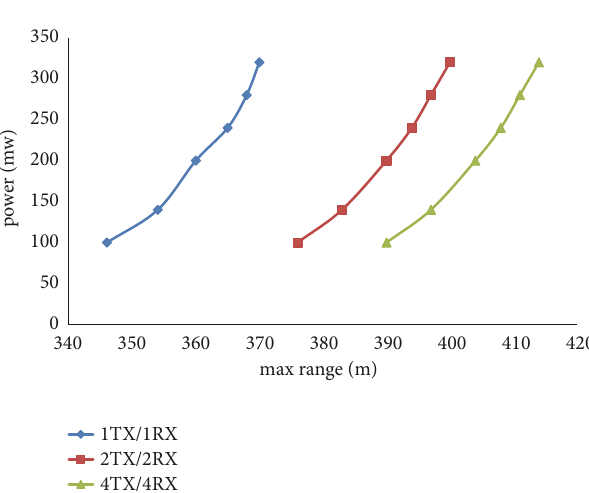
Figure 11: Power (mw) and max range (m) at 𝜆 =1550nm and 𝛼 =190.9db/km (heavy